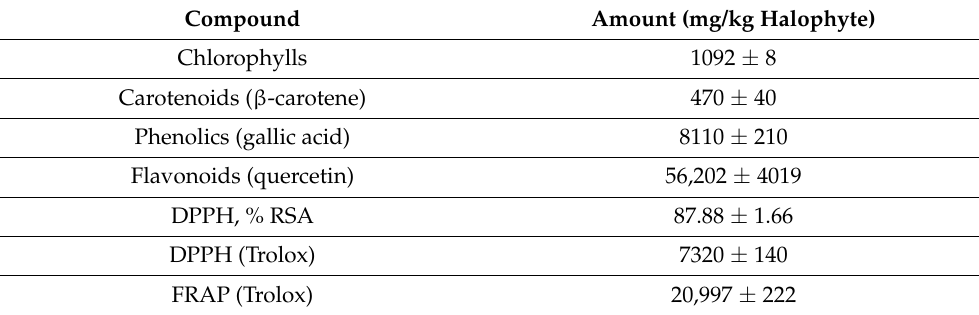
Table 2. Concentration of pigments, total phenolic content, and antioxidant activity (assayed by DPPH and FRAP methods) in Crithmum maritimum (d.w.) (average values ± standard deviations of three